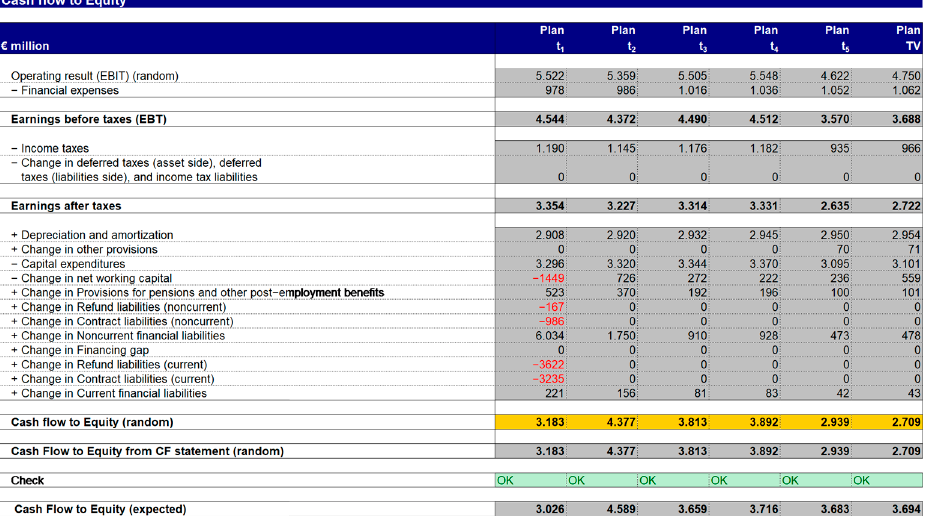
Figure 5. Calculation of the cash flow to equity.